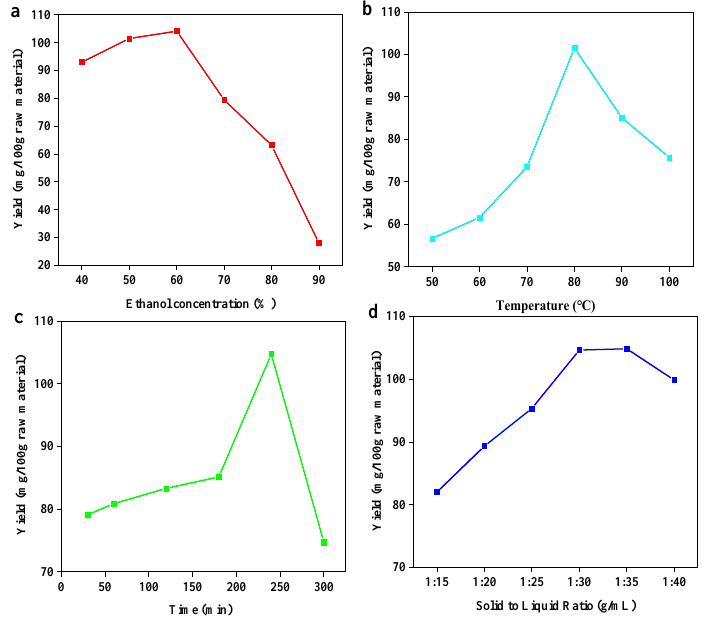
Figure 1. E ff ect of ethanol concentration ( a ); temperature ( b ); time ( c ); and solid to liquid ratio ( d ) on the extraction yield of total flavonoids.